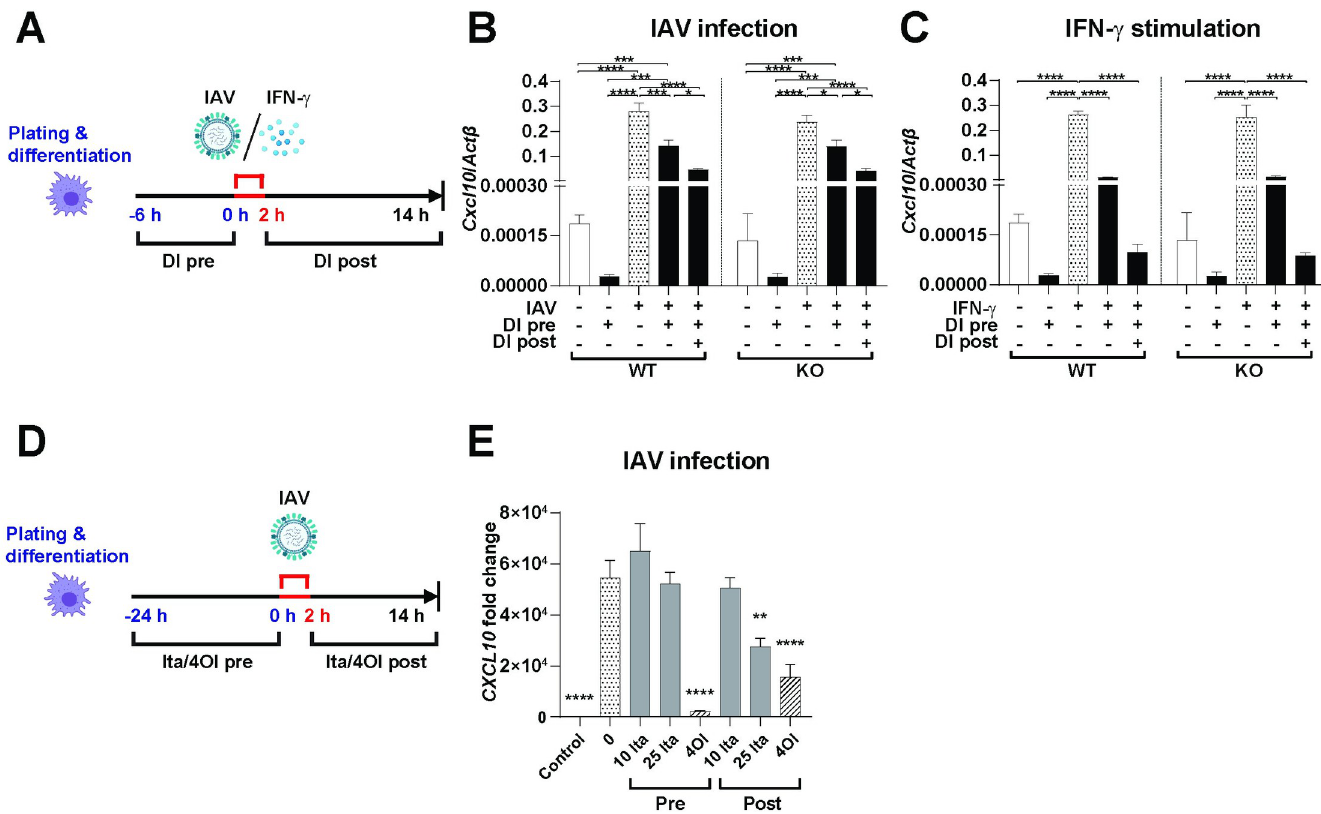
Fig 4. Effects of endogenous Acod1 ( Irg1 ) gene and timing of compound administration on anti-inflammatory activity of itaconates. A-C. Effect of endogenous ACOD1 . BMDMs from WT or Acod1 -/- C57BL/6N mice were preincubated with DI (0.25 mM) for 6 h, infected with IAV (PR8M, MOI = 1) or stimulated with IFN- γ (15 ng/ml) for 2 h, and then subjected to post-infection/stimulation treatment with DI (0.25 mM) for another 12 h as indicated. Uninfected/unstimulated cells were exposed to 6 h treatment only. Expression of Cxcl10 mRNA was determined by RT-qPCR, using β -actin as internal control. A. Outline of experiment. B. CXCL10 mRNA expression after IAV infection. C. CXCL10 mRNA expression after IFN- γ stimulation. D,E. Effect of timing of compound administration. dTHP1 cells were infected with IAV (PR8M, MOI = 1) and subjected either to pre-incubation (24 h) or post-infection treatment (12 h) with itaconate (10, 25 mM) or 4OI (125 μ M). Expression of Cxcl10 mRNA was determined by RT-qPCR, using β -actin as internal control. Reference for fold change = uninfected, untreated 14 h. D. Outline of experiment. E . CXCL10 mRNA expression. Mean ± SEM (n = 3). � p < 0.05; �� p < 0.01; ��� p < 0.001; ���� p < 0.0001 (two-way ANOVA with Fisher’s LSD test for multiple comparisons in C,D ; one-way ANOVA with Dunnett’s multiple comparison test in C